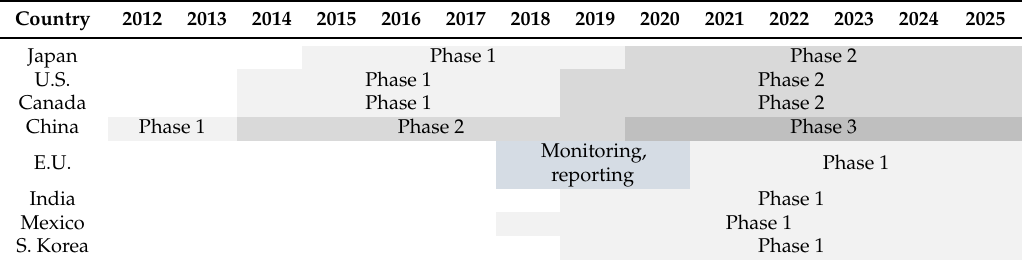
Table 1. Estimated implementation timelines for medium- and heavy-duty vehicle (MHDV) CO 2 emission standards [10].